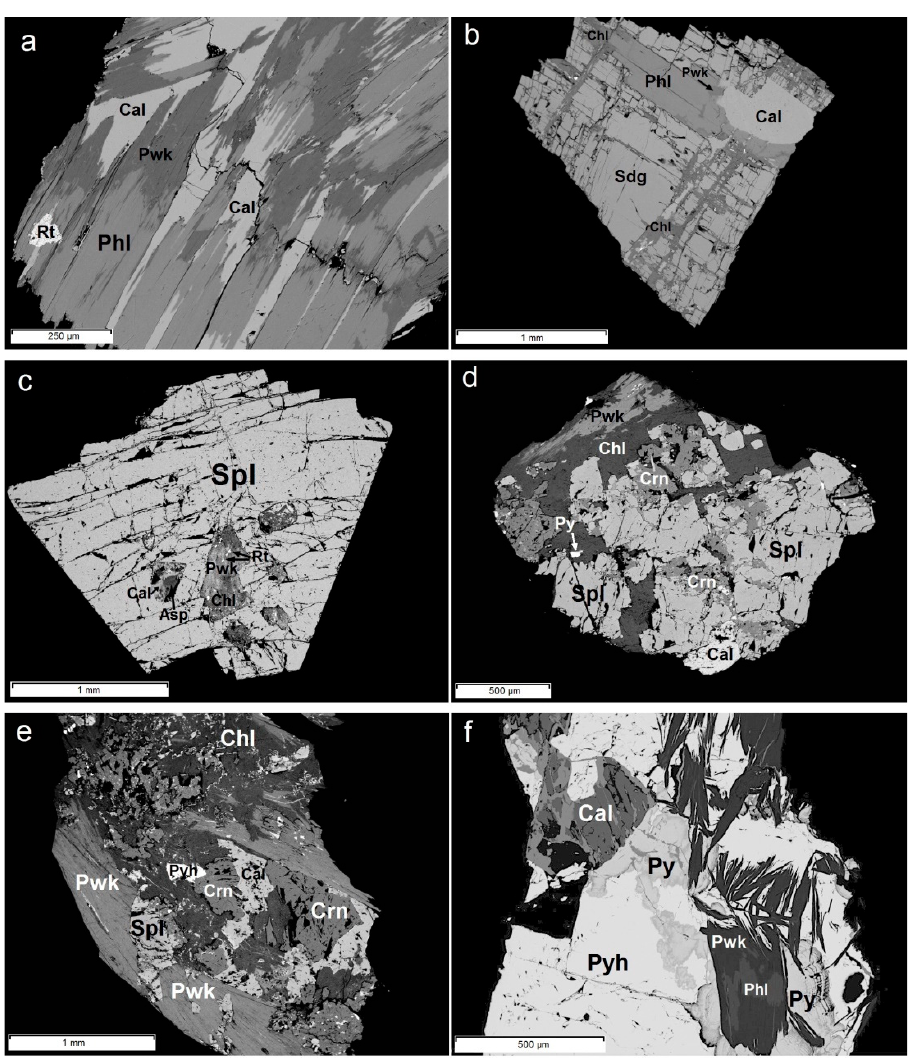
Figure 2. Back-scattered electron scanning electron microscopy images of a polished section of the Luc Yen preiswerkite: ( a ) preiswerkite replacing phlogopite in calcite matrix; ( b ) preiswerkite replacing phlogopite in association with sadanagaite and calcite; ( c ) preiswerkite + chlorite + rutile inclusions in spinel grains; ( d ) preiswerkite altered to chlorite at the rim in association with violet spinel replacing corundum; ( e ) preiswerkite and chlorite in association with violet spinel overgrowing corundum grains; ( f ) preiswerkite replacing phlogopite in association with calcite, pyrite and pyrrhotite. Mineral symbols [30]: Asp—aspidolite; Cal—calcite; Chl—chlorite; Crn—corundum; Phl—phlogopite; Pwk—preiswerkite; Py—pyrite; Pyh—pyrrhotite; Rt—rutile; Sdg—sadanagaite; Spl—spinel.